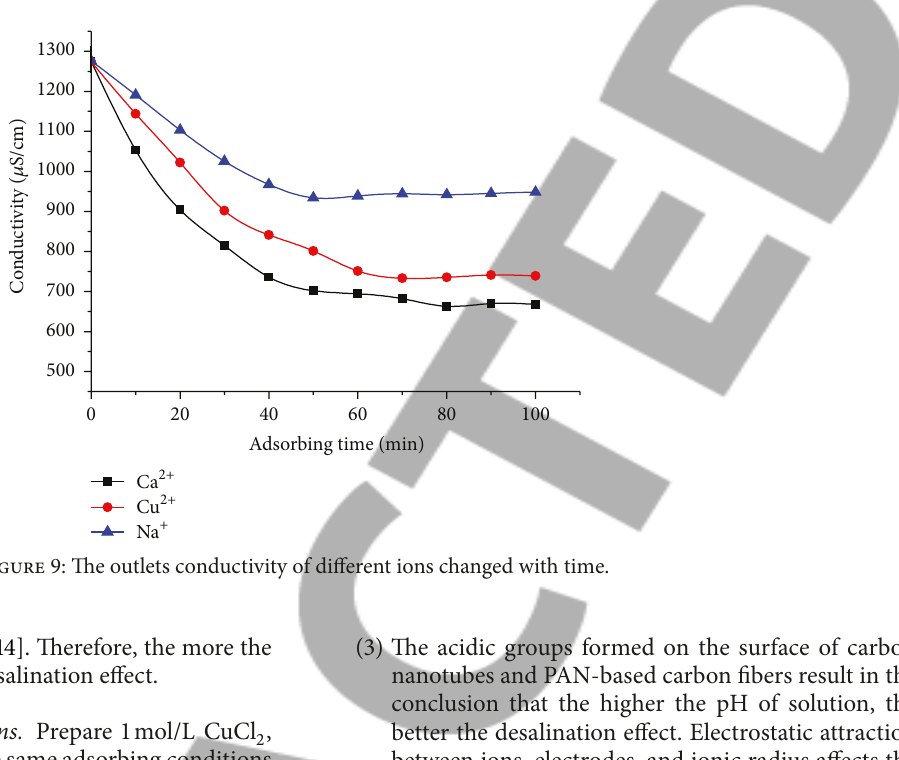
Figure 9: The outlets conductivity of different ions changed with